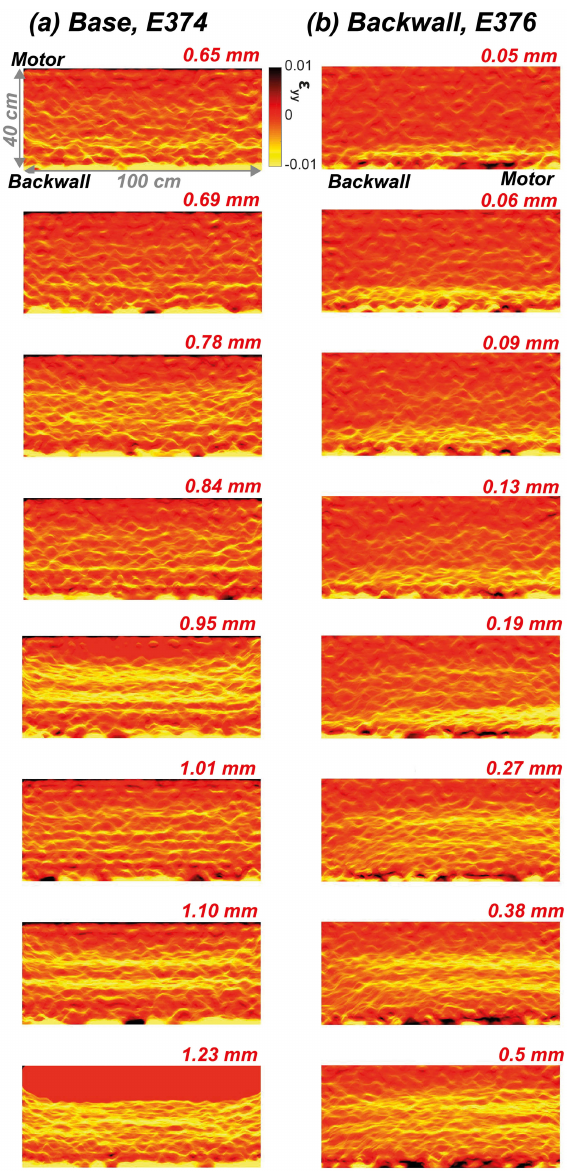
Figure 9. Normal strain perpendicular to the backwall from top views of experiments (a) E374 (moving base) and (b) E376 (mov- ing backwall). Contraction is negative. Y axis is perpendicular to the backwall. Red numbers show the cumulative backwall displace- ment. The motor is located at the top in the moving-base (a) and at the bottom in the moving-backwall (b) experiment. Preceding thrust fault development, the extent of the compacting region differed de- pending on the apparatus configuration. This difference produces changes in the effective stiffness estimates and internal work esti-